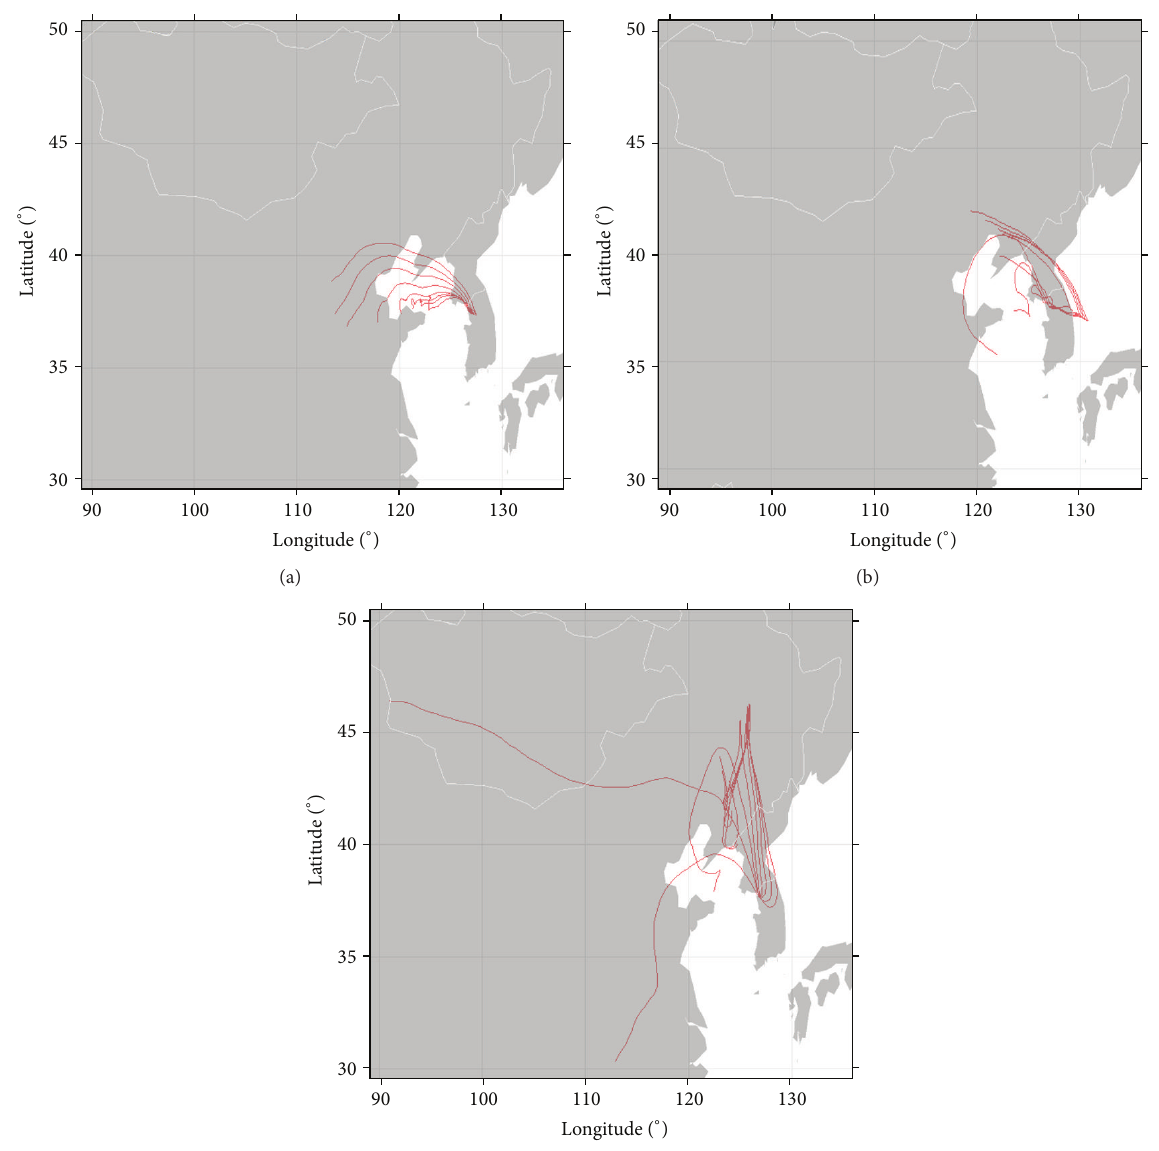
Figure 3: Backward trajectory (a) in the former period of Case 1 , (b) in the latter period of Case 1 , and (c) in Case 2 .